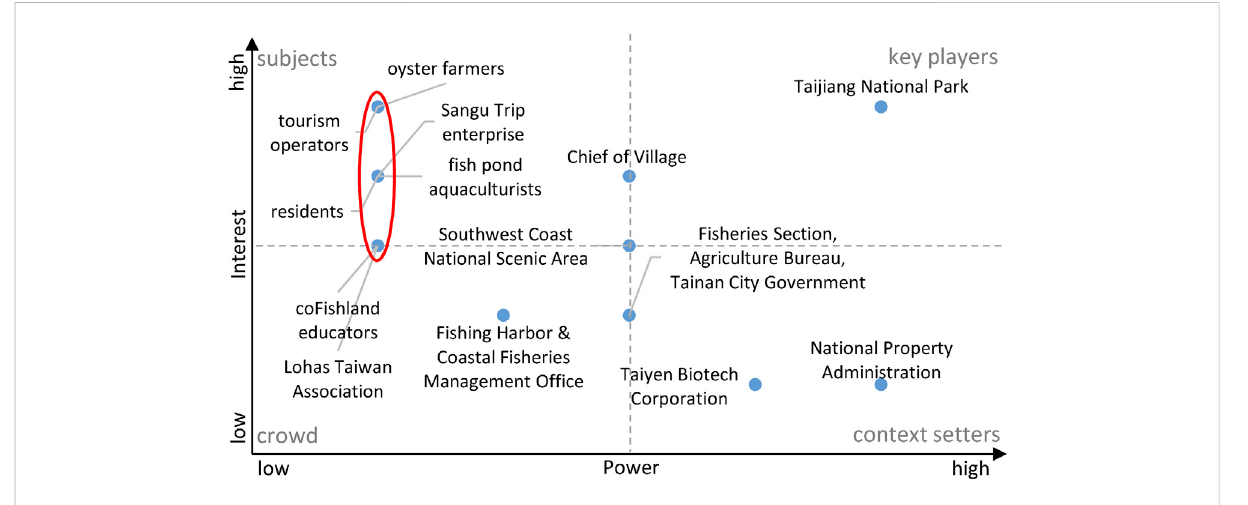
FIGURE 6 Power – interest grid for Cigu ’ s socioeconomic